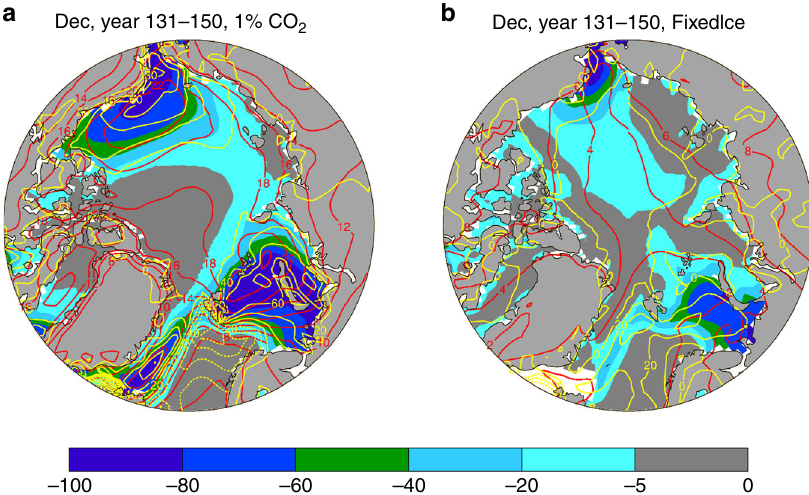
Fig. 10 Mean changes (relative to the control-run climatology) for year 131 – 150. a from the 1% CO 2 run and b from the FixedIce run. Shown are changes in December sea-ice concentration (SIC, %, color shading), surface air temperature (Tas. °C, red contours, interval = 2), and surface latent plus sensible heat fl ux ((LH + SH, W m − 2 , yellow contours, interval = 10, positive upward). Dashed contours are for negative values. The spatial pattern correlations are: r (SIC, Tas) = − 0.20, r (SIC, LH + SH) = − 0.75, and r (Tas, LH + SH) = 0.55 in a , and r (SIC, Tas) = 0.12, r (SIC,LH + SH) = − 0.45, and r (Tas, LH + SH) = − 0.28 in b . These correlations have a P -value below